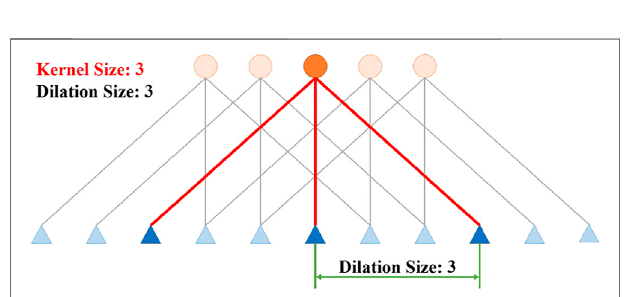
FIGURE 3 | The illustration of 1D Dilation Convolution. Dilation size indicates the spacing between the convolution kernel points.